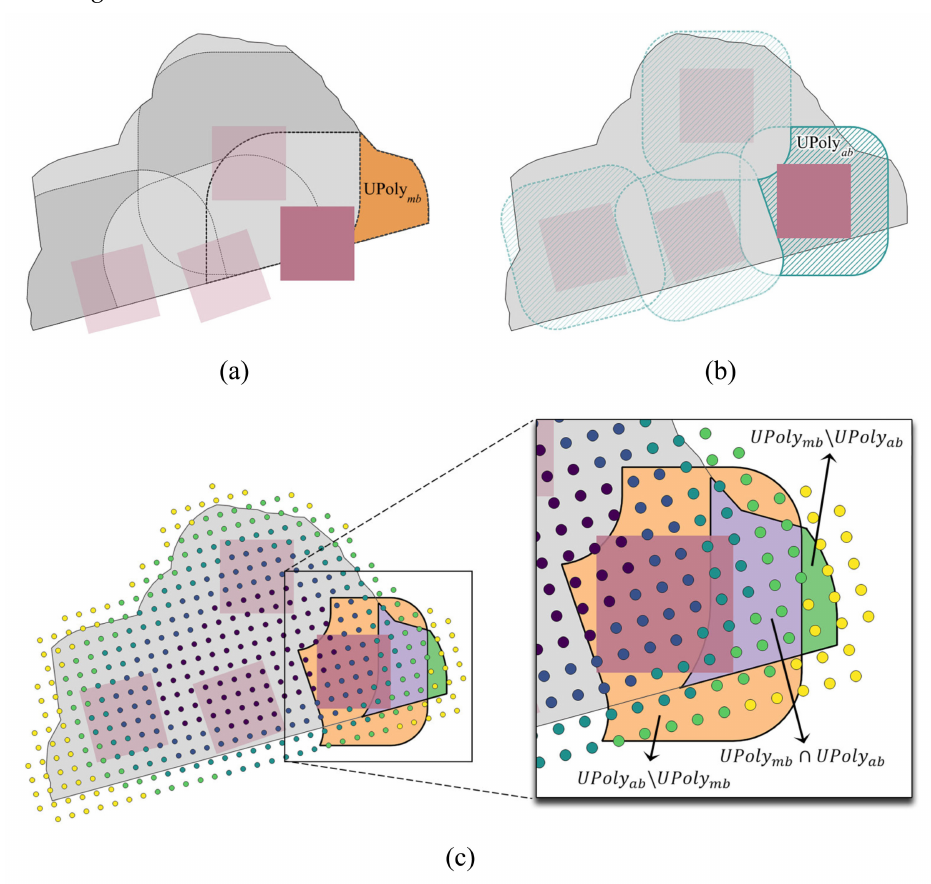
Figure 9. Elements of grid point weight modification in the example of a building: ( a ) unique polygon of the main buffer ( UPoly mb ), ( b ) unique polygon of the auxiliary buffer ( UPoly ab ), ( c ) grid points colored by KDE-based initial weights and topologic conditions for their